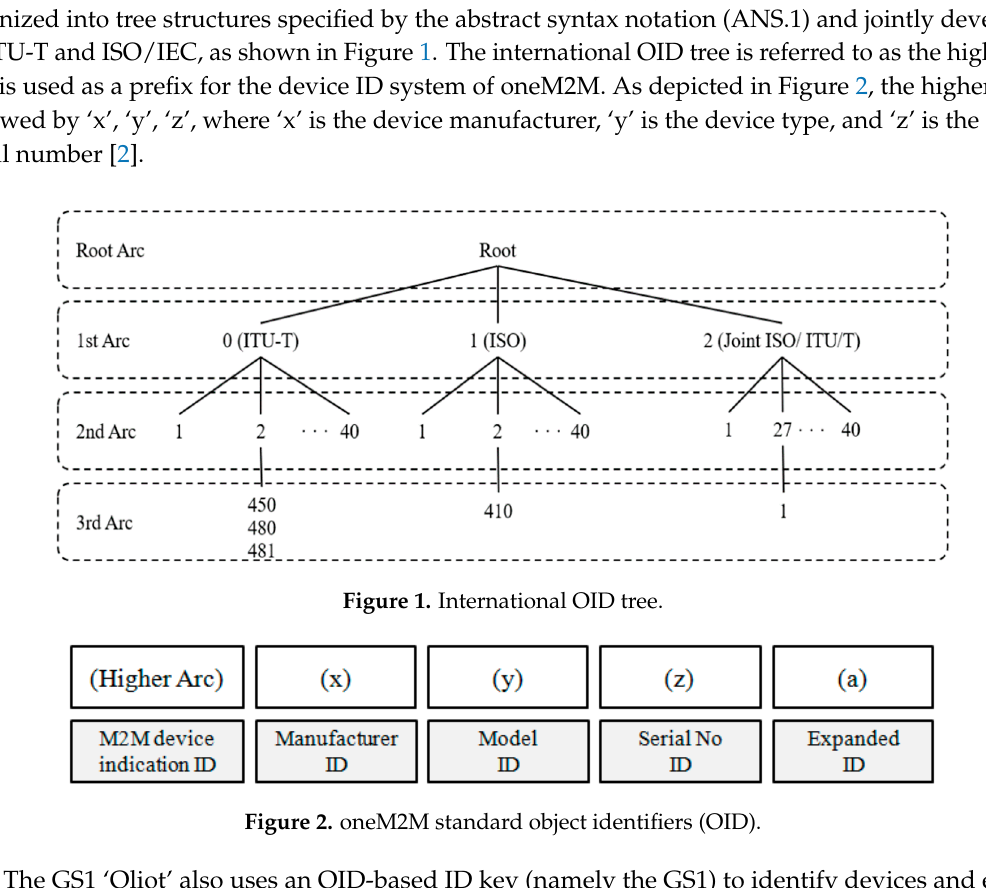
Table 1. Comparison of four Internet of Things (IoT) platforms’ identification systems.